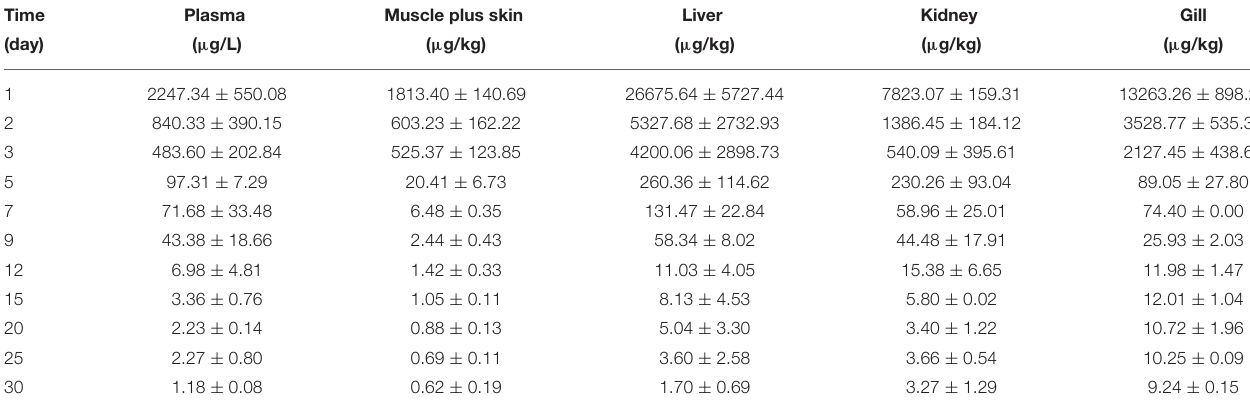
TABLE 3A | The tiamulin concentrations in plasma and tissues of Nile tilapia after daily oral administration of a single dose of 20 mg/kg for 5 days at 19 ◦ C ( n = 6). Time Plasma Muscle plus